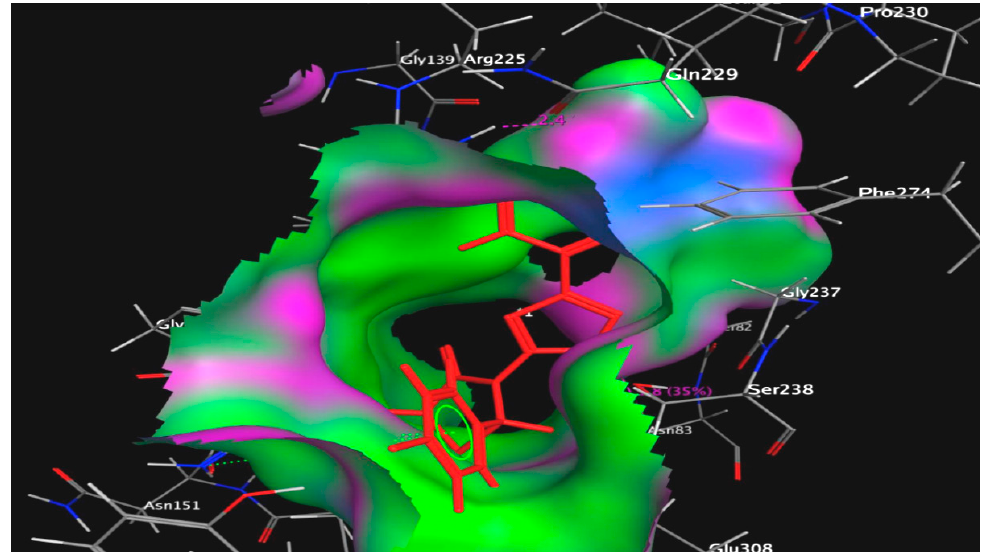
Figure 8. Surface map for the MurB active site with the docked conformation of Compound 7h (red stick) (pink: hydrogen bond; blue: mild polar; green: hydrophobic region).